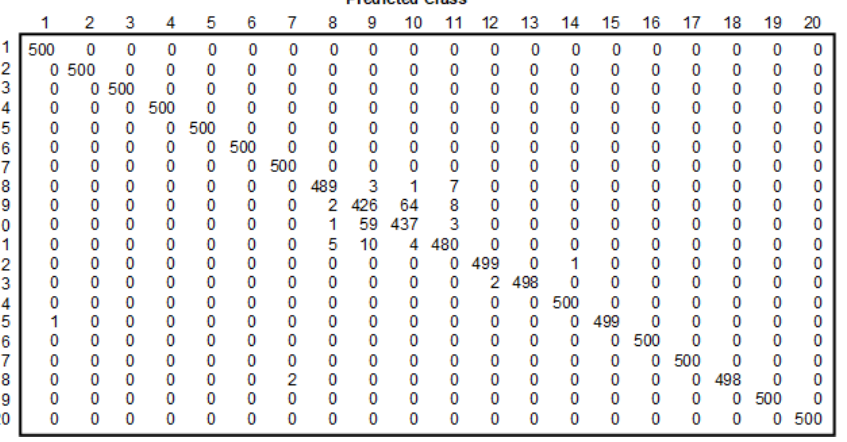
Figure 19. Confusion matrix. Table 15. Results of image